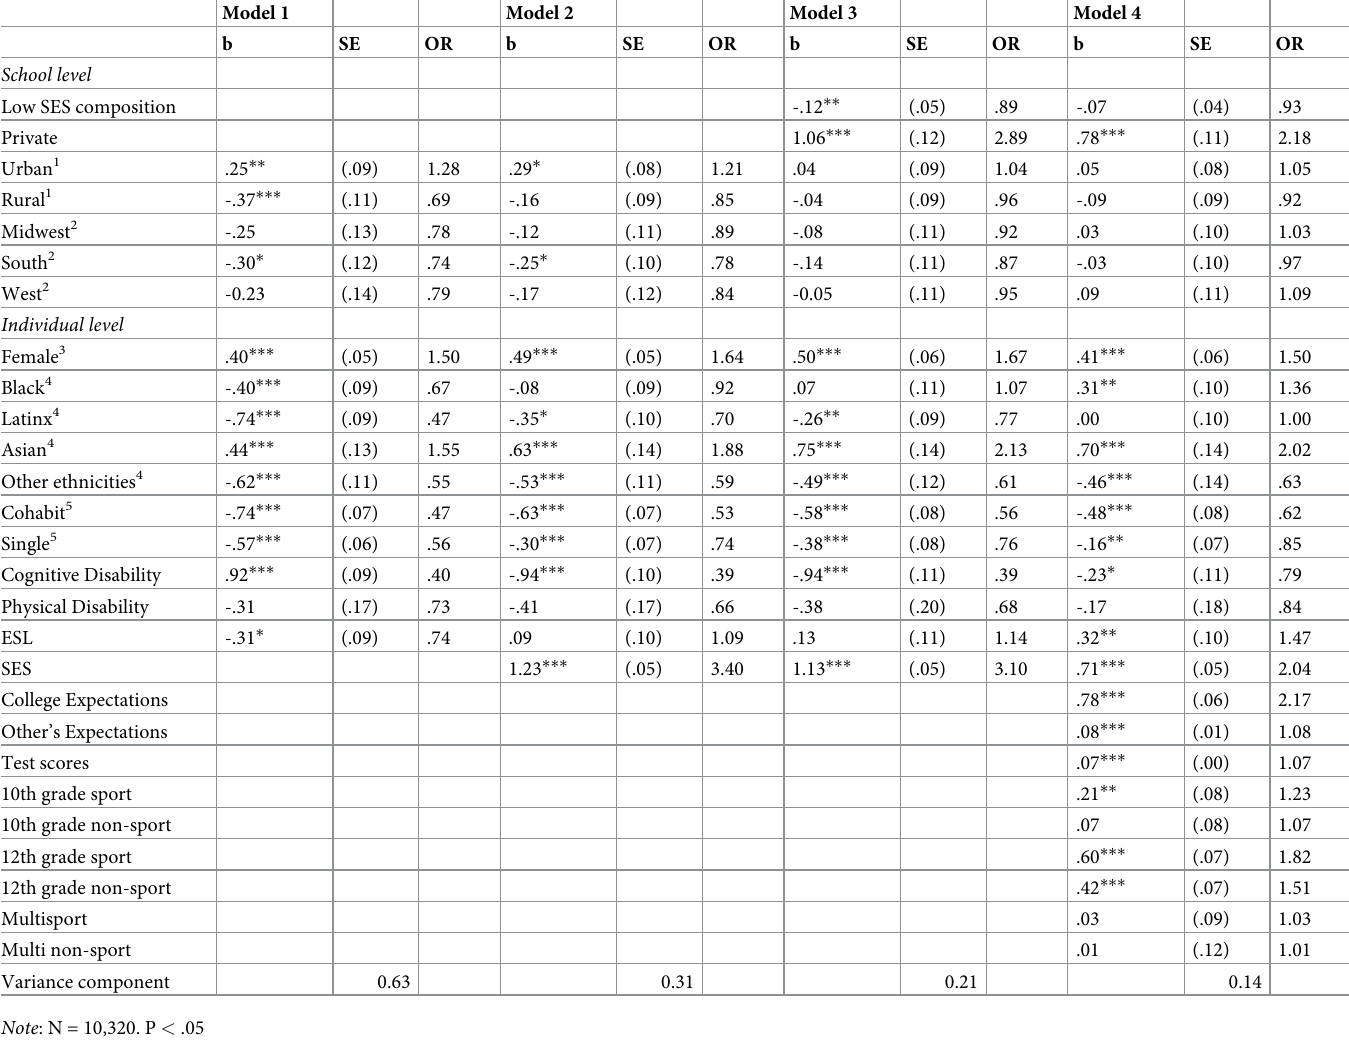
Table 1. Multilevel logistic regressions predicting the likelihood of attending